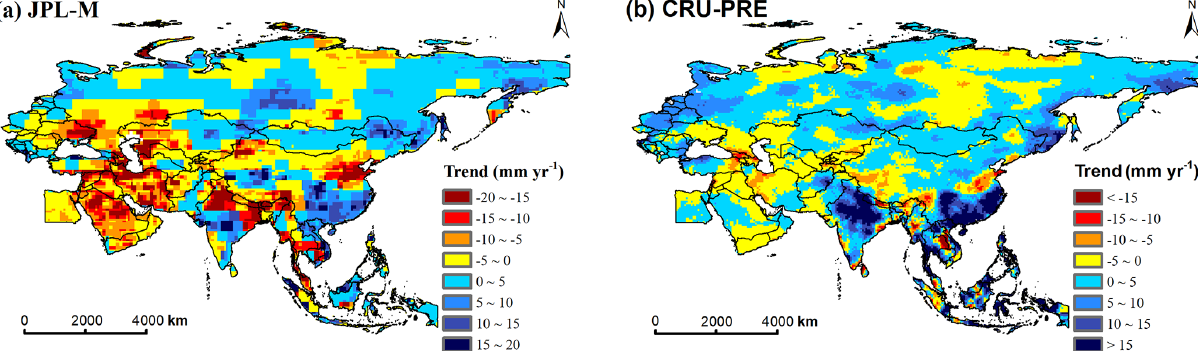
Figure 3. Spatiotemporal changes in TWS as obtained from GRACE (a) and precipitation as obtained from CRU (b) across the Asian and eastern European regions during 2002–2017. The trend is obtained from the removed seasonal cycle time series.